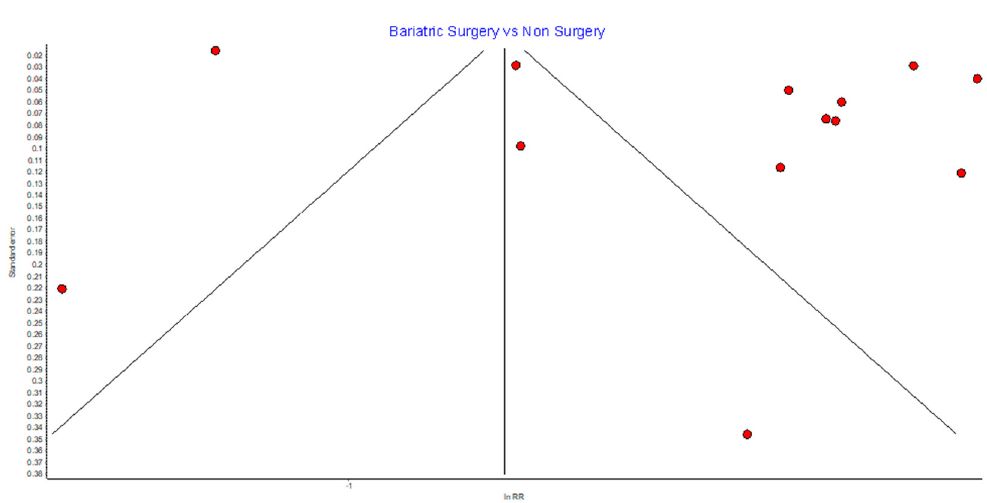
Figure A1. Overall cancer incidence RE model funnel plot. Table A1. Overall cancer incidence RE model sensitivity analysis.